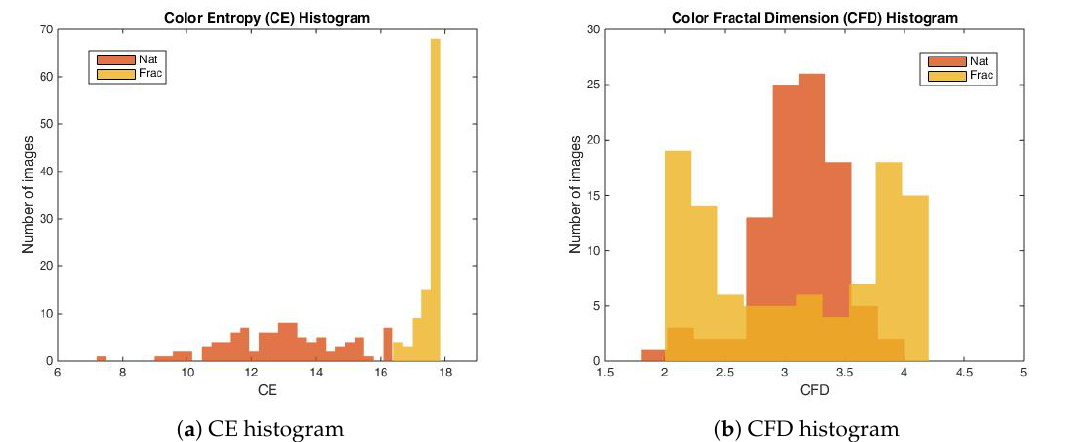
Figure 3. Color entropy (CE) and Color Fractal Dimension (CFD) histogram for Nat (in light red) and Frac images (light orange), computed with: ( a ) Five bins (for Nat) and 31 bins (for Frac), ( b ) computed with 10